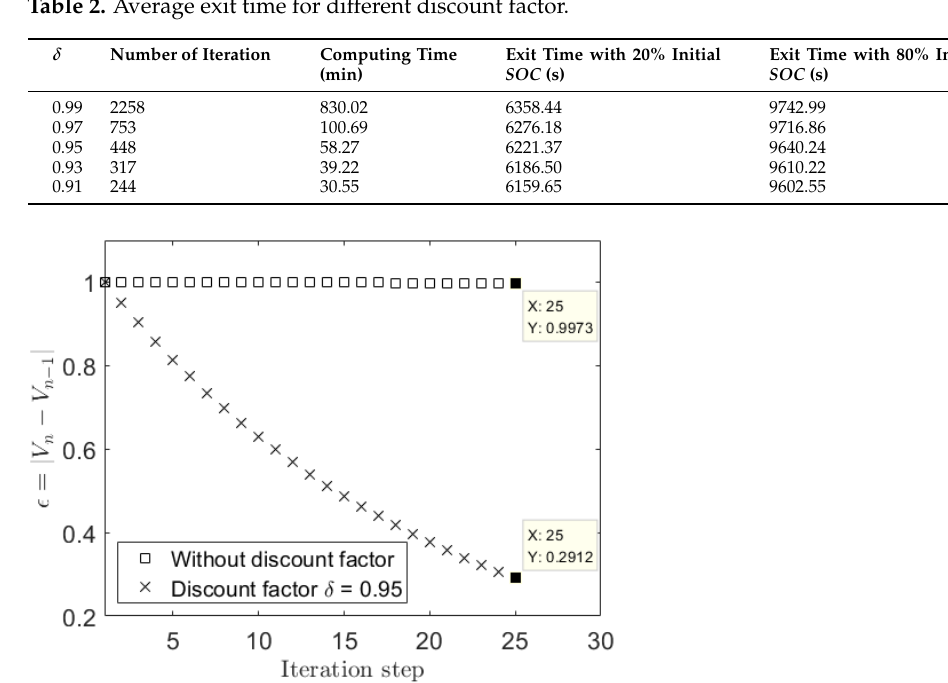
Figure 5. The effect of the discount factor in the value iteration